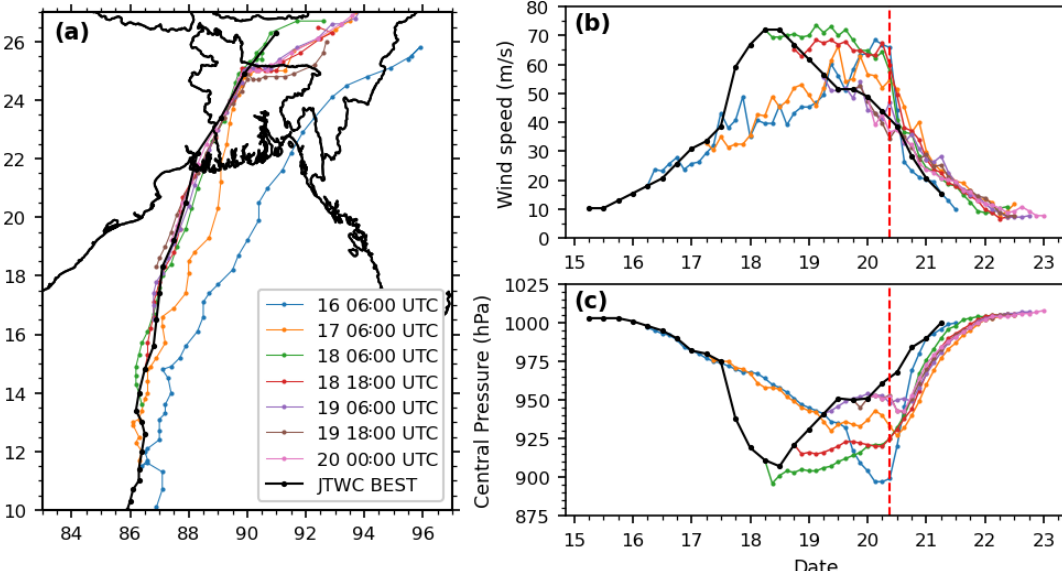
Figure 3. Temporal evolution of the successive forecasts of Amphan cyclone wind and pressure. (a) Forecast track colour-coded with the date (JTWC best track in black). (b) Wind speed forecast with each epoch. (c) Pressure forecast with each epoch. The vertical dashed red line indicates the time of